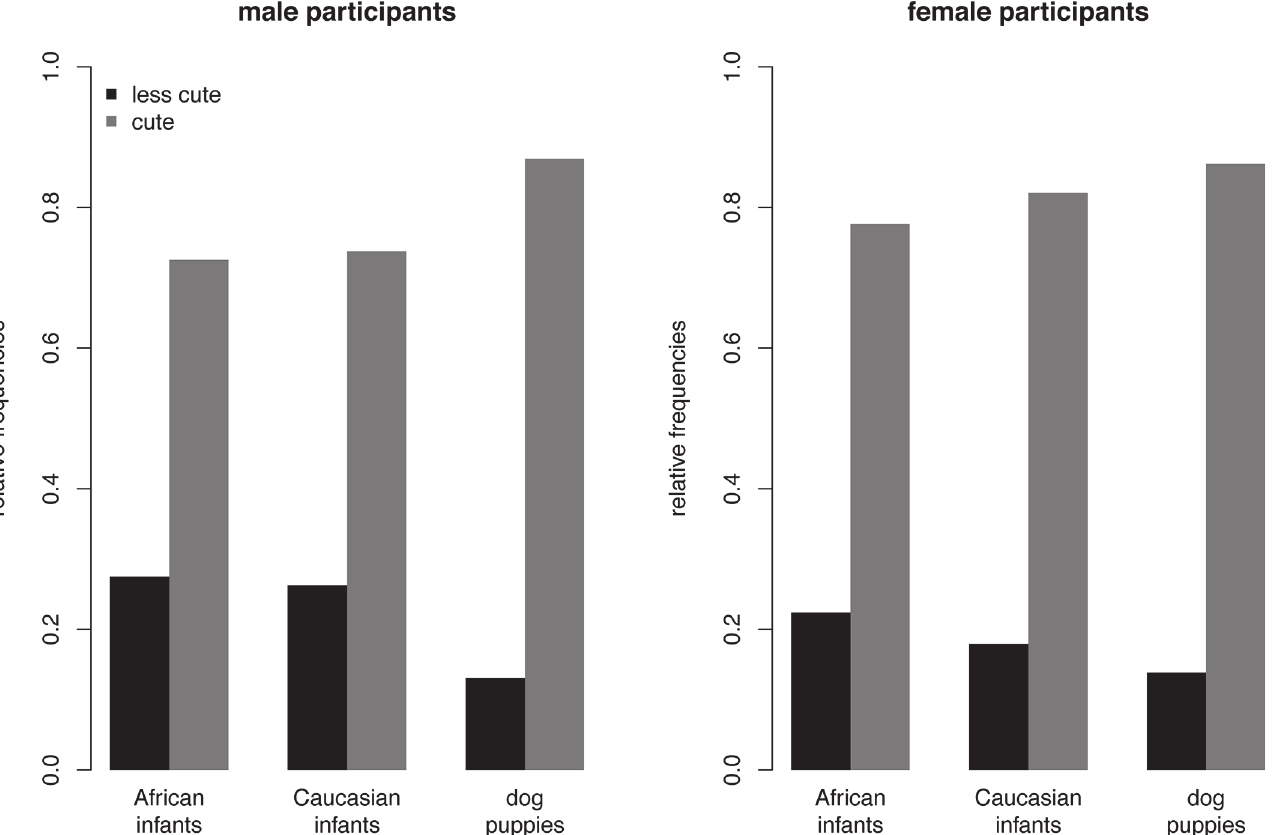
Fig 2. Descriptive statistics of Study 1: Adoption-Task. Relative frequencies are presented for cute and less cute faces being chosen for each stimulus category and separately for male and female